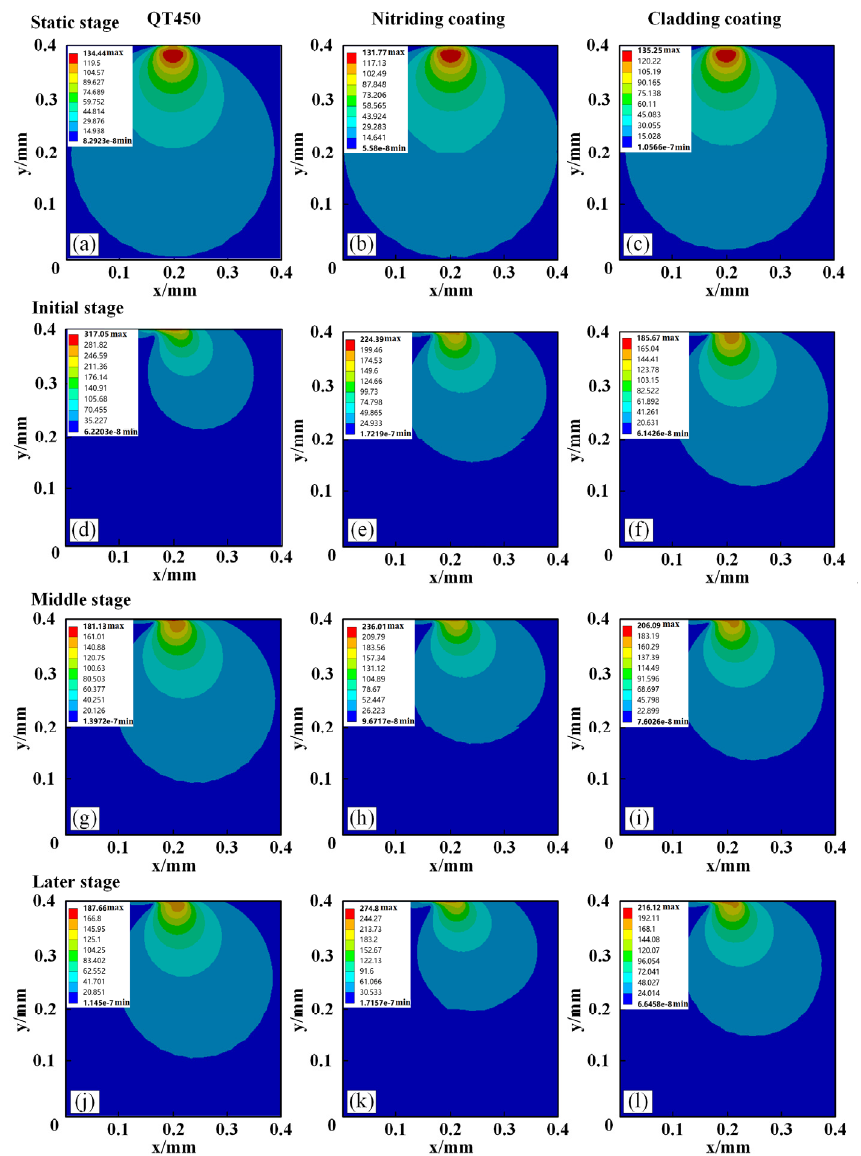
Figure 10. Von Mises stress distribution of three samples at different friction coefficients: ( a ) static stage of substrate;( b ) static stage of nitriding layer; ( c ) static stage of cladding layer; ( d ) initial stage of substrate ( e ) initial stage of nitriding layer;( f ) initial stage of cladding layer;( g ) middle stage of substrate;( h ) middle stage of nitriding layer; ( i ) middle stage of laser cladding;( j ) later stage of substrate;( k ) later stage of nitriding layer;( l ) later stage of cladding layer.